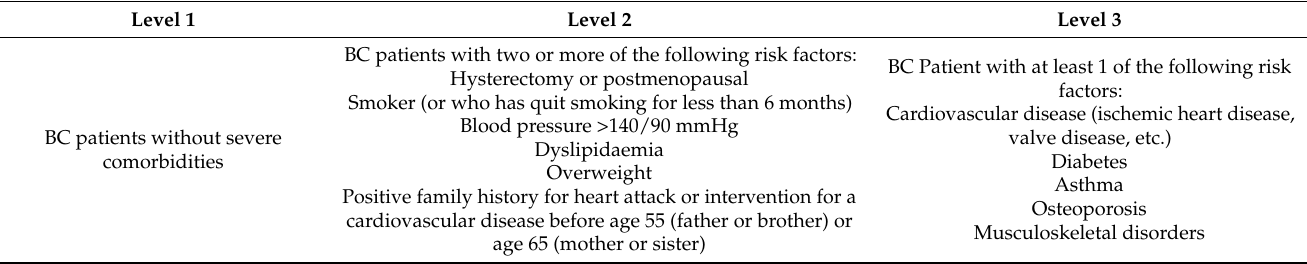
Table 1. Risk levels based on patients’ comorbidities.